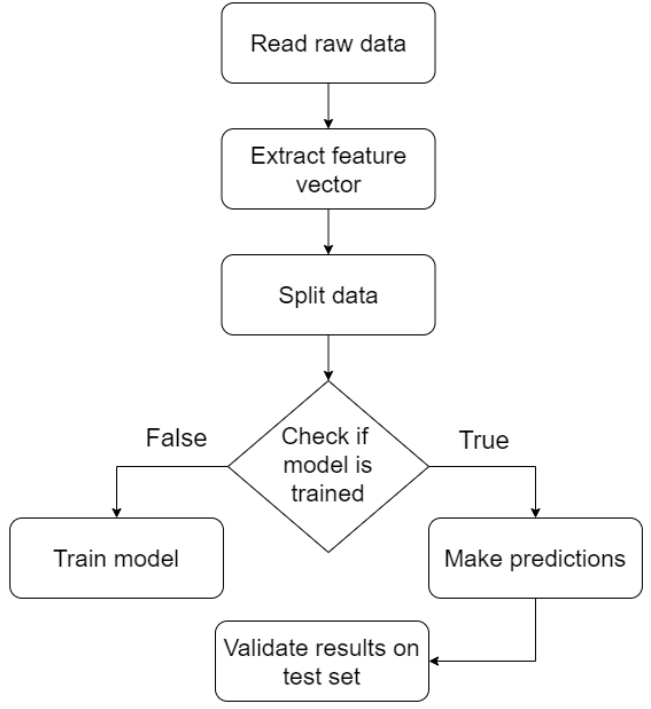
Figure 3. Machine learning pipeline.